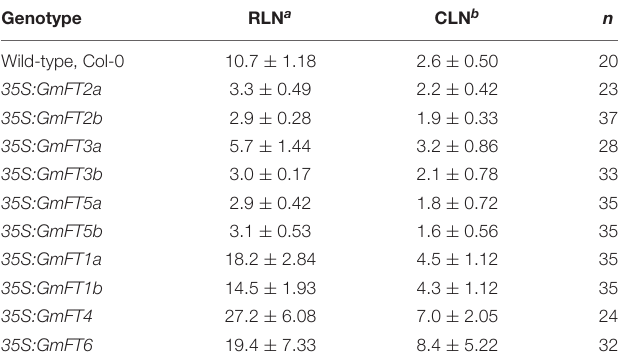
TABLE 1 | Flowering times determined by leaf number in long-day